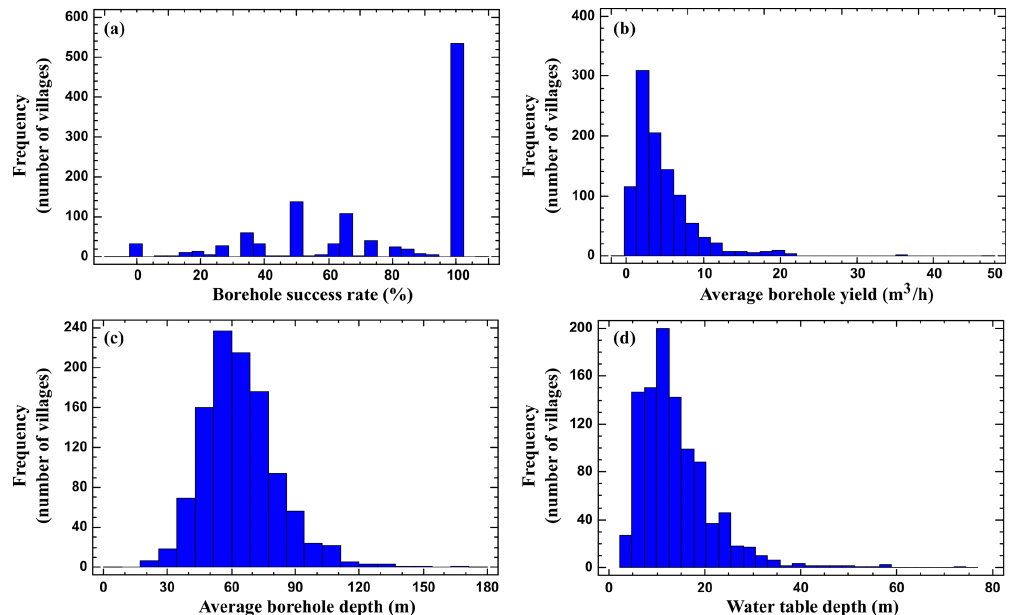
Figure 5. Frequency analysis of the four borehole-related variables: (a) borehole success rate, (b) average borehole yield, (c) average borehole depth and (d) water table